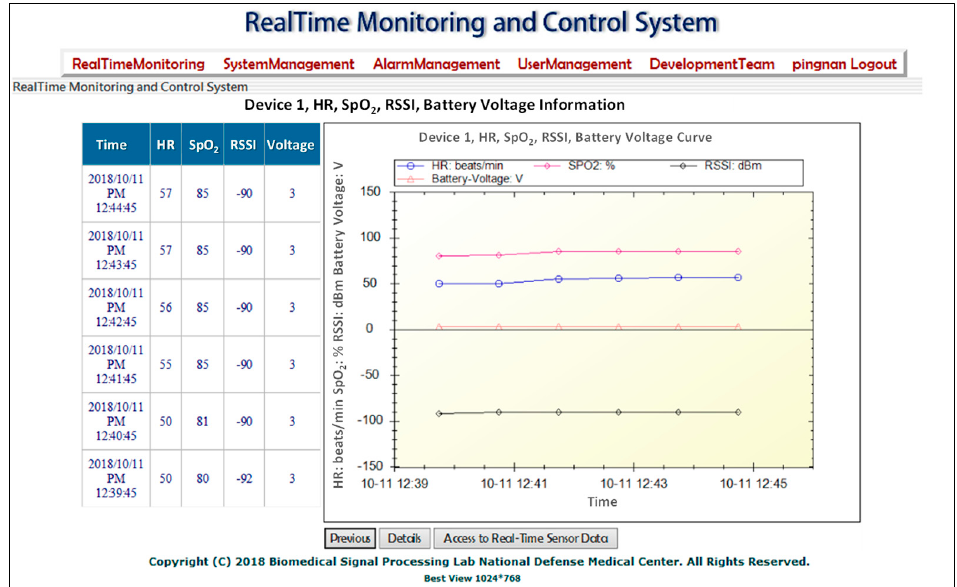
Figure 14. Display parameter data and curves of the selected sensor node.